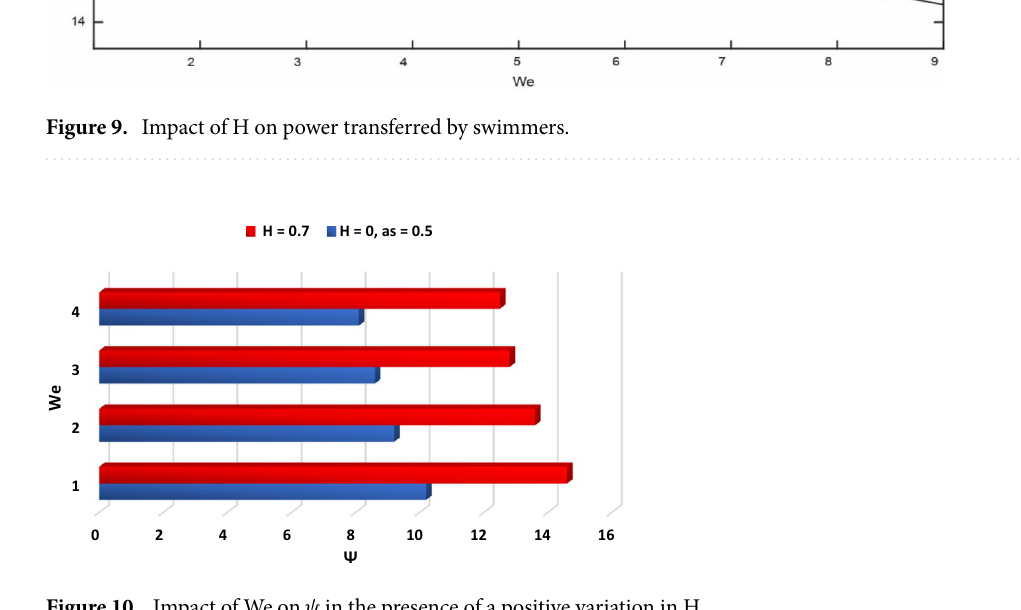
Figure 10. Impact of We on ψ in the presence of a positive variation in